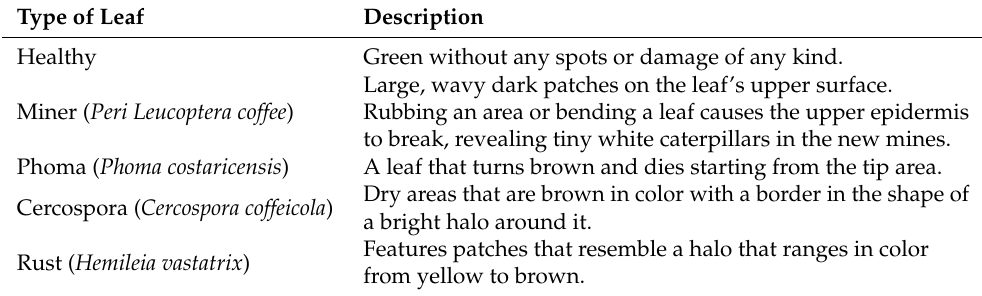
Table 4. Detailed class dataset.